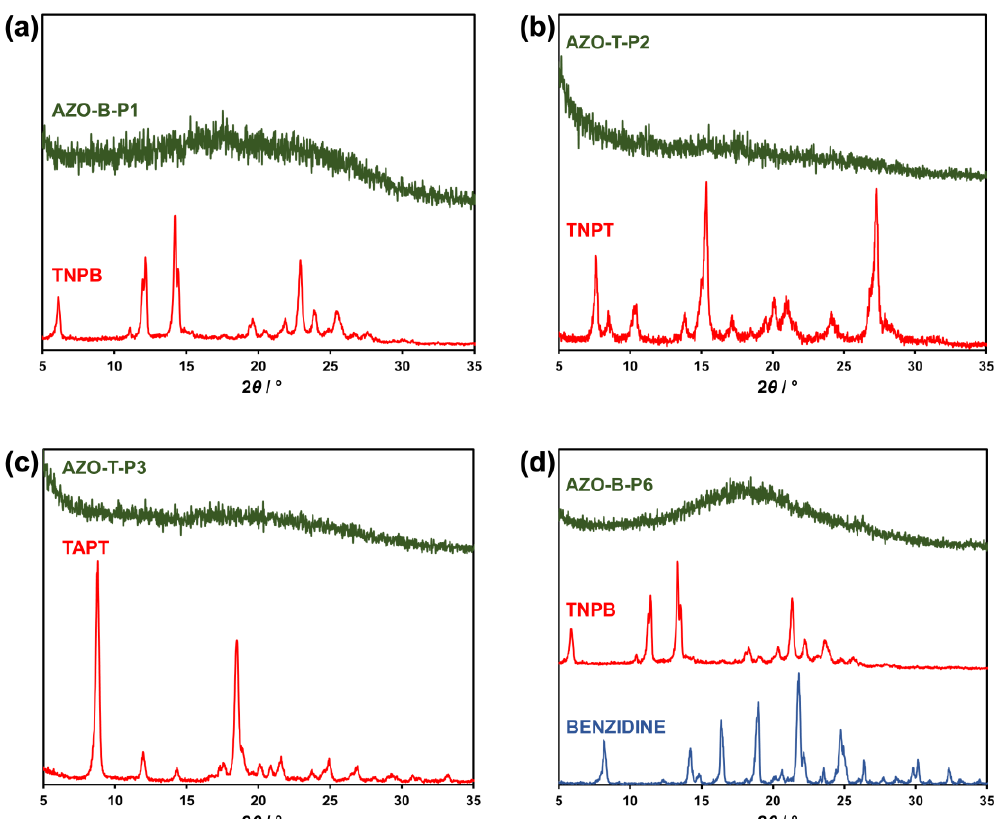
Figure 4 . Comparison of representative PXRD patterns of ( a ) AZO-B-P1 polymer and starting nitro monomer (TNPB); ( b ) AZO-T-P2 polymer and starting nitro monomer (TNPT); ( c ) AZO-T-P3 polymer and starting amino monomer (TAPT); ( d ) AZO-B-P6 polymer and starting nitro and amino monomers (TNPB and benzidine, respectively).